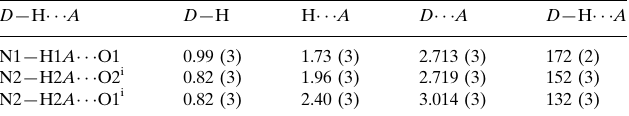
Hydrogen-bond geometry (A˚ , (cid:3)